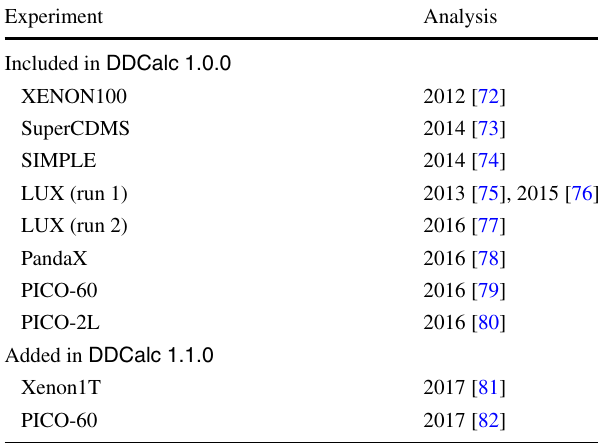
Table 2 Experimental analyses included in DDCalc Experiment